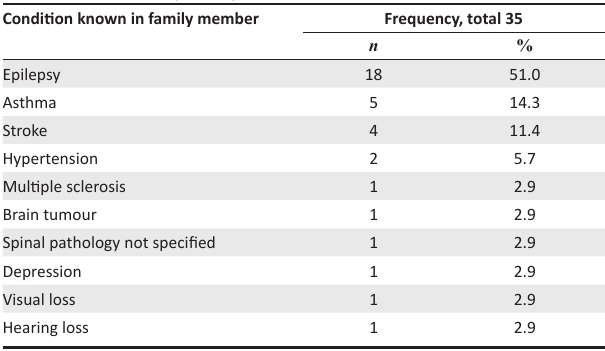
TABLE 7: Positive family